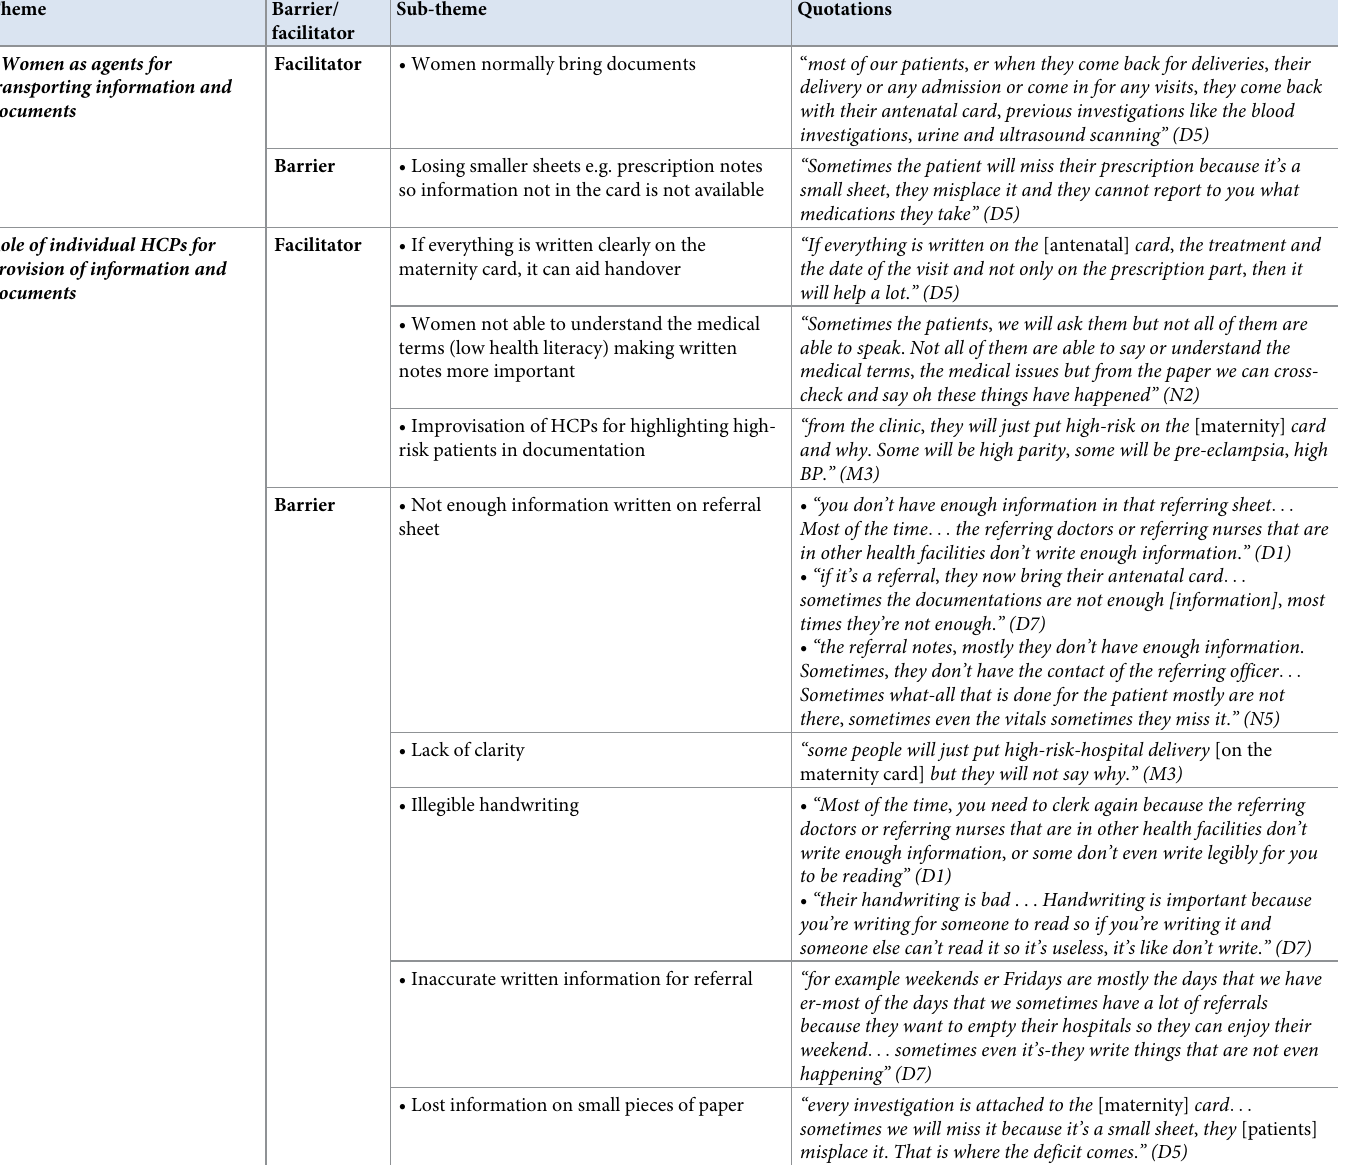
Table 4. Qualitative results support quotations of barriers and facilitators to effective handover on admission through use of